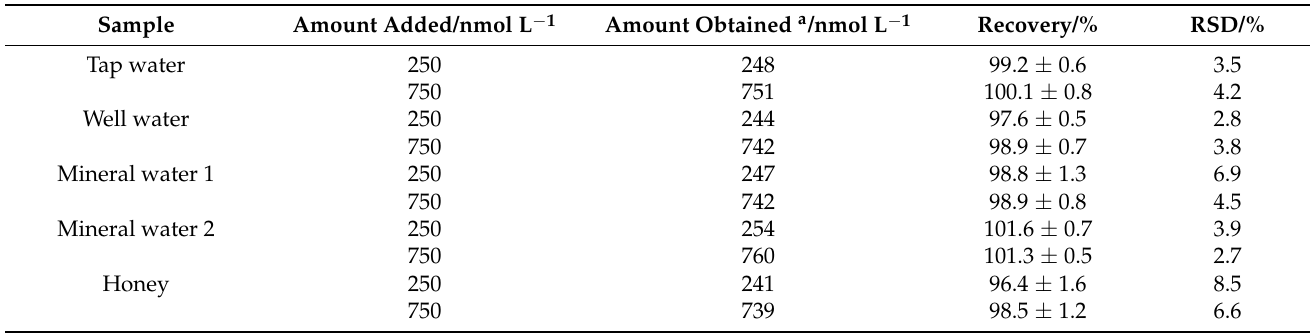
Table 4. Results of Cd 2+ and Pb 2+ determination in spiked